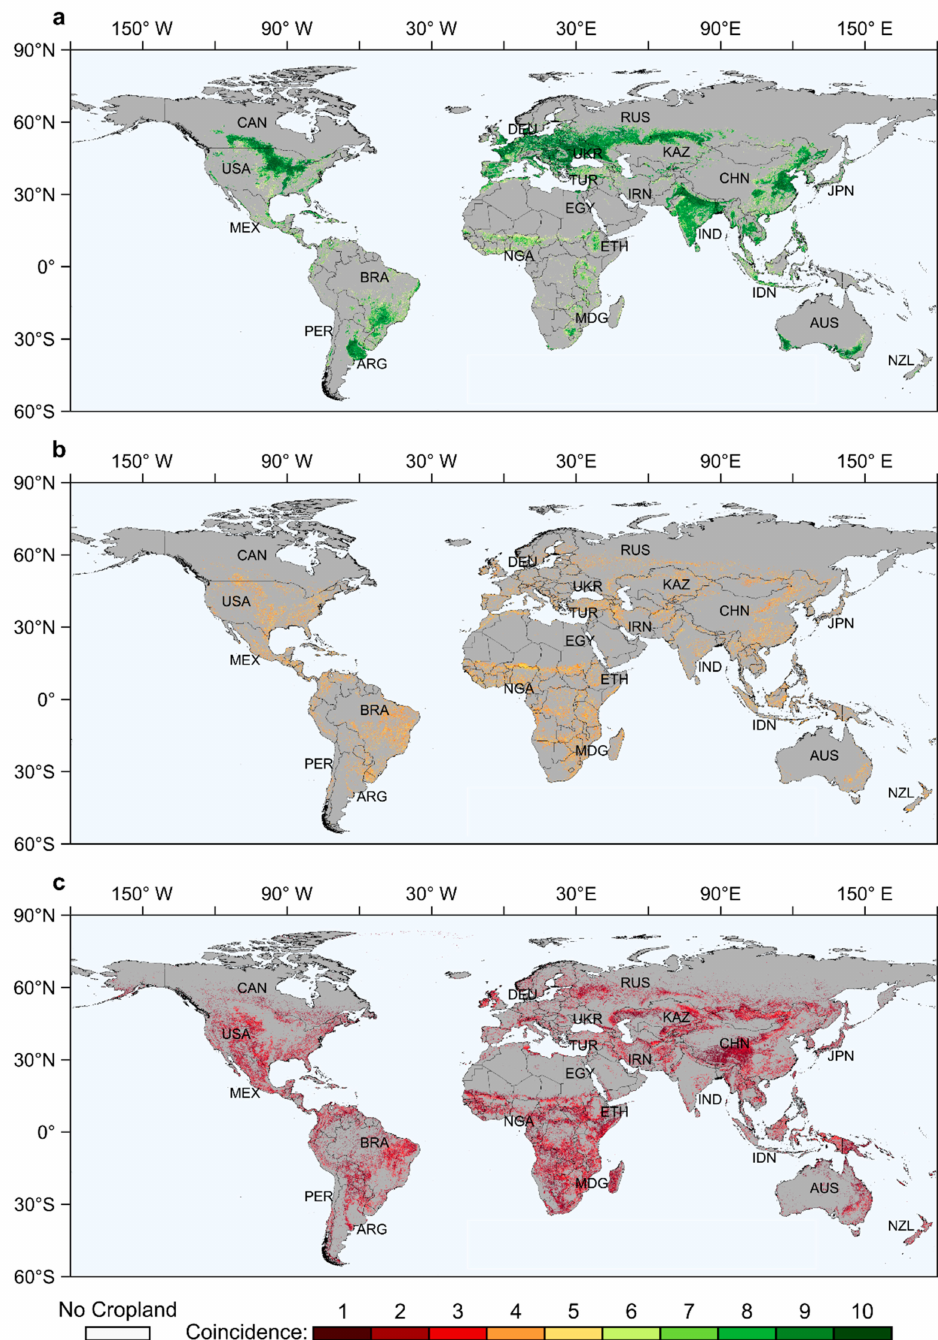
Figure 1. Coincidence degree of the cropland distribution around the world. The three di ff erent coincidence levels are shown separately. ( a ) is the high coincidence of cropland distribution, ( b ) is the moderate coincidence of cropland distribution, and ( c ) is the low coincidence of cropland